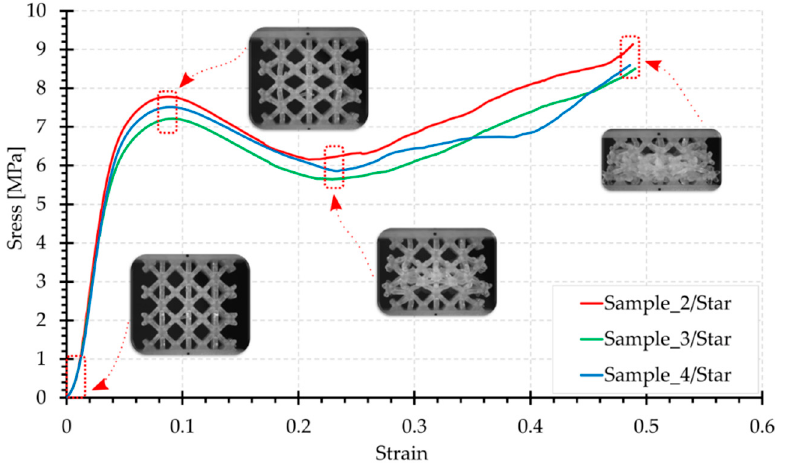
Figure 8. Compression curve for the Star structure with photographs of the topology at selected test phases.